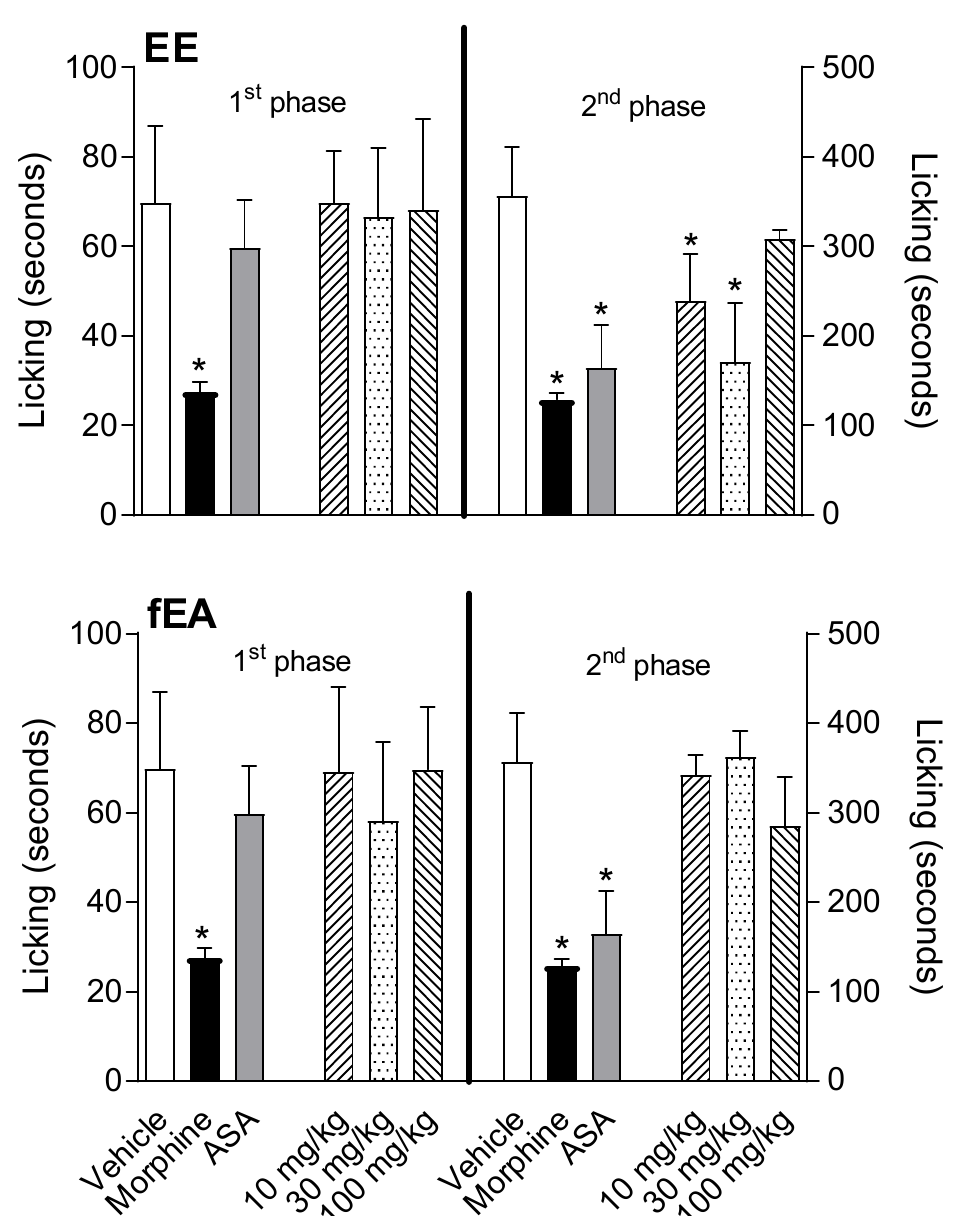
Figure 3. Effect of the ethanol extract (EE) or fraction in ethyl acetate (fEA) from leaves of T. granulosa in the formalin-induced licking behavior. The animals were pre-treated with vehicle, morphine (2.5 mg/kg), ASA (200 mg/kg), EE or fAE (10, 30 or 100 mg/kg), 60 min before the intra-plantar injection of formalin (2.5% v / v ). The results are presented as mean ± S.D. of the time (seconds) that animals kept licking their formalin-injected paws ( n = 6). The statistical significance (* p < 0.05) had been calculated comparing the groups pre-treated with EE, fEA, morphine, or ASA with the group pre-treated with vehicle, using ANOVA followed by post-test of